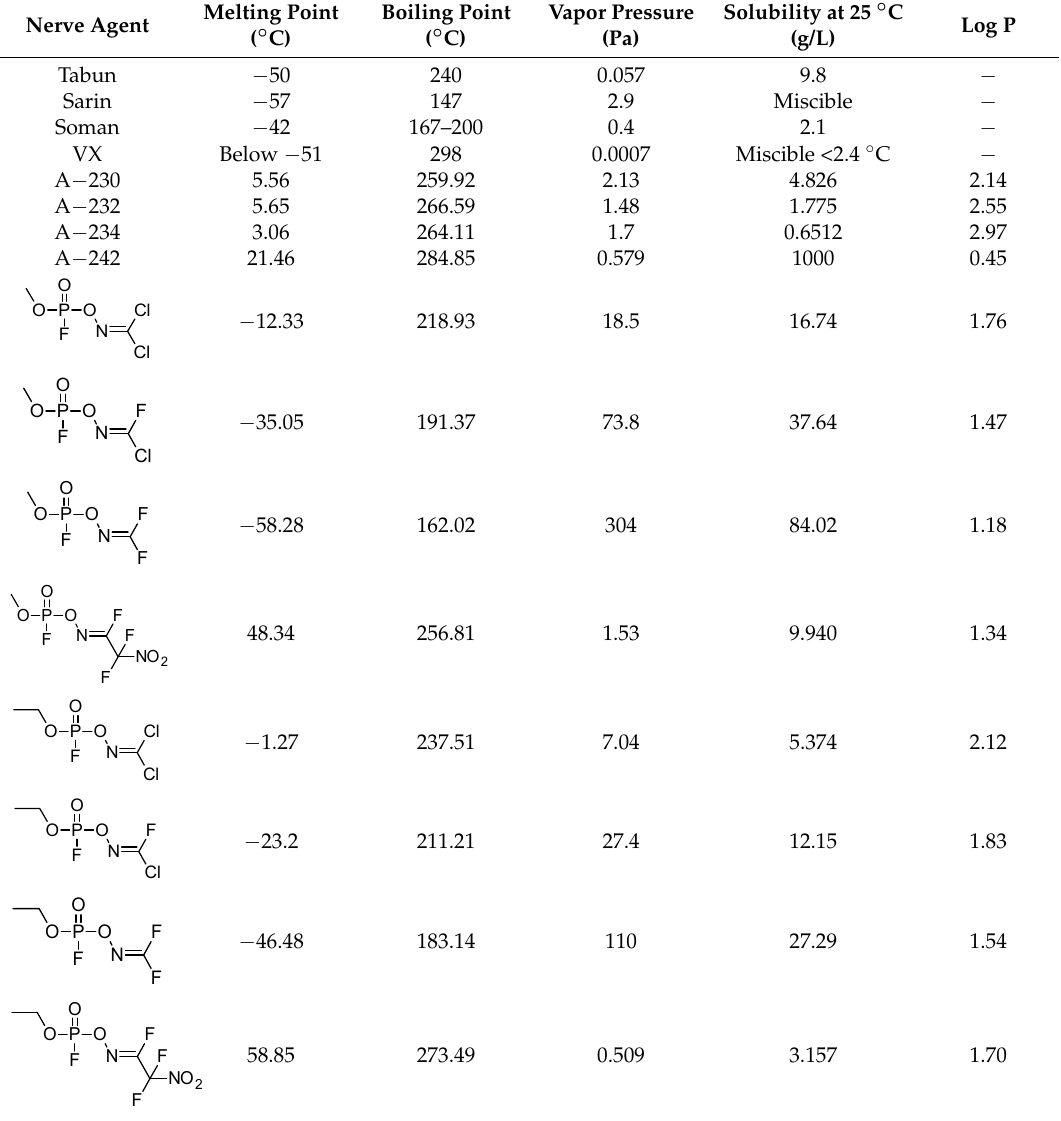
Table 1. Physical-chemical properties of some nerve agents